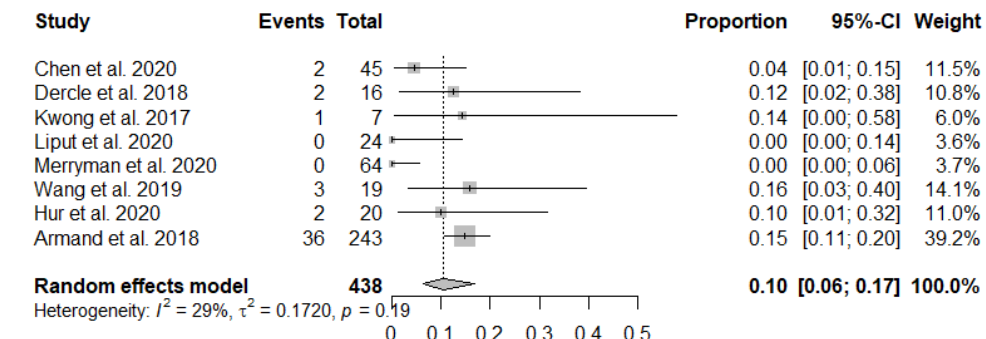
Figure 3. Forest plots to show the pooled incidence of pseudoprogression.